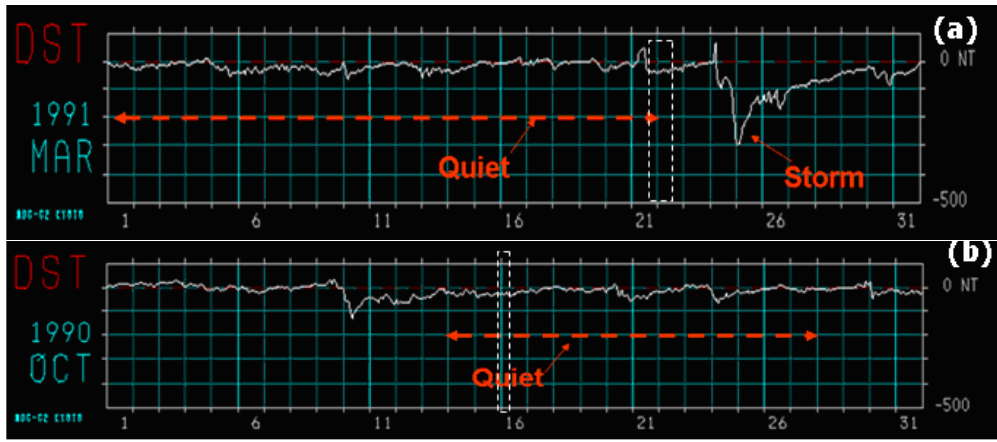
Fig. 4. The magnetic activity during the observation period of each event that these are not severely disturbed time, but already disturbed in some periods. The dash rectangle shows the date for each event. (a) 21 and 22 March 1991. (b) 5 October 1990. (This data is provided by World Data Center (WDC) Kyoto.)